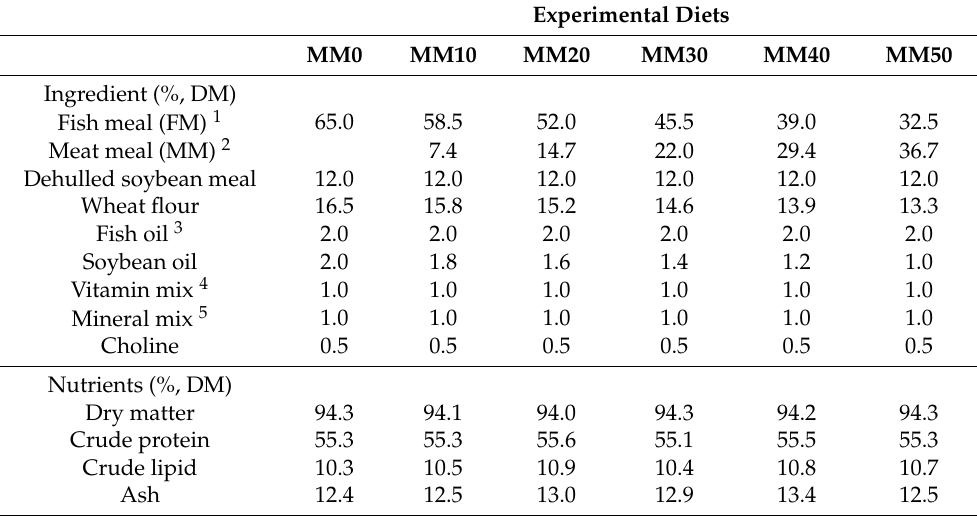
Table 1. Ingredients of the experimental diets (%, DM